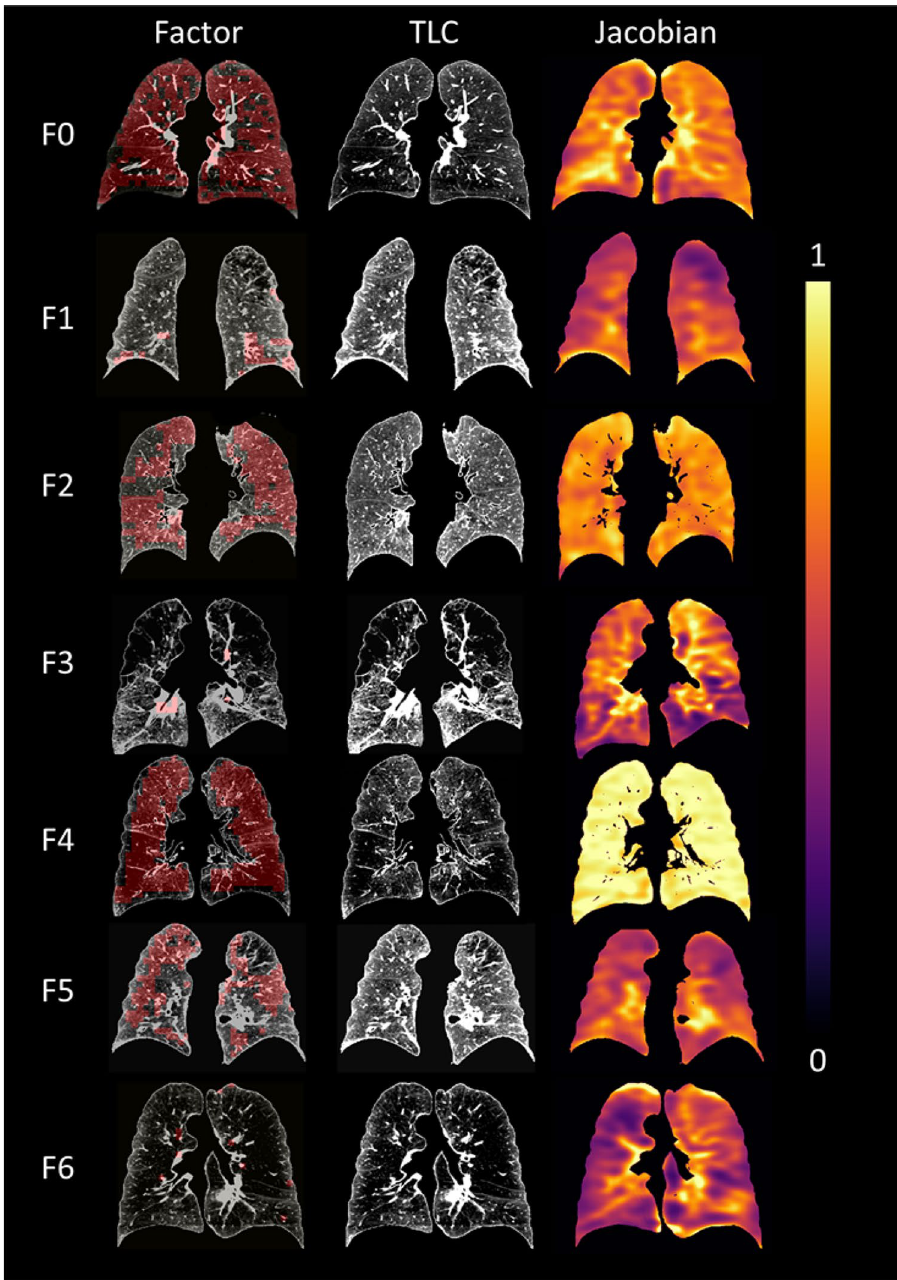
Figure 3. Factor-representative subjects (i.e. 99th percentile of the factor score among the subjects), shown in a coronal view (posterior–anterior). The pattern-clusters with strong contribution to each factor, ranging from F0 to F6, are shaded with red on the images in the left column. TLC images with CT intensities are displayed in the middle. Jacobian images are shown in the right